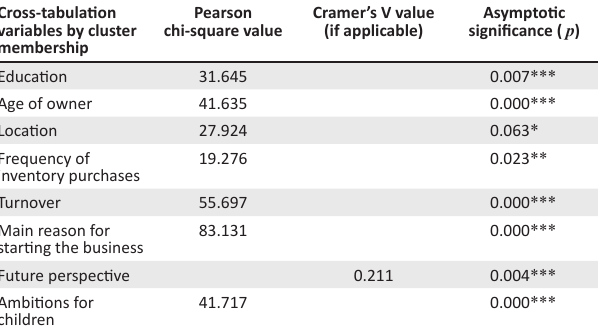
TABLE 3: Results of Pearson chi-square test and Cramer’s V values when determining cluster membership and selected variables. Cross-tabulation variables by cluster